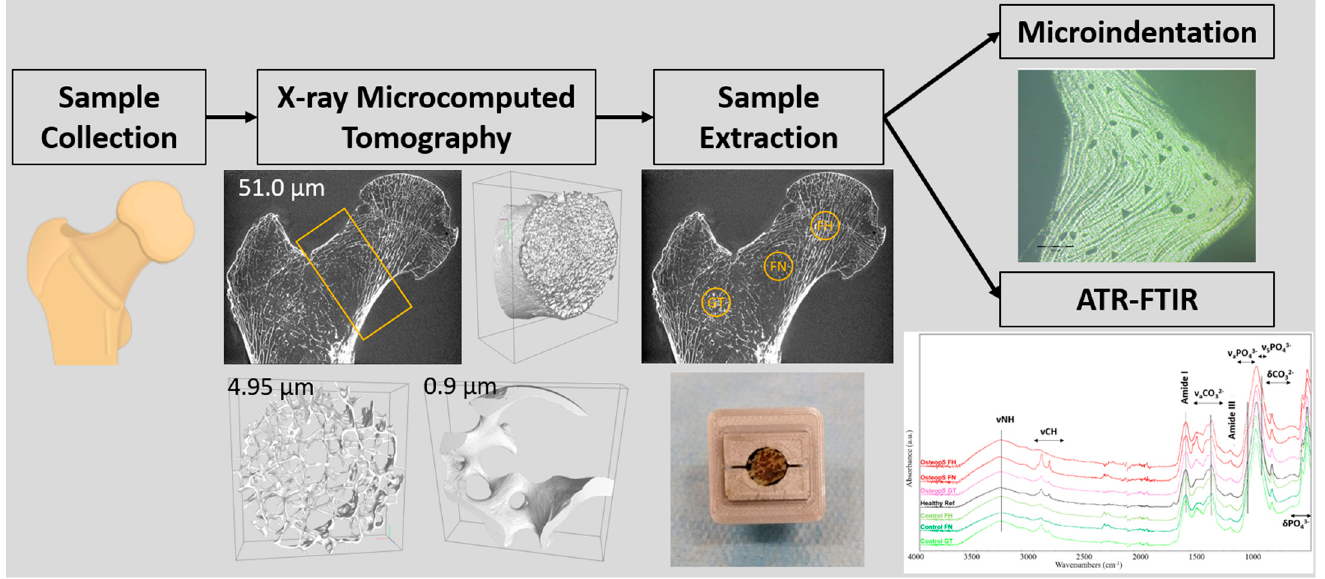
Figure 1. Experimental study workflow.